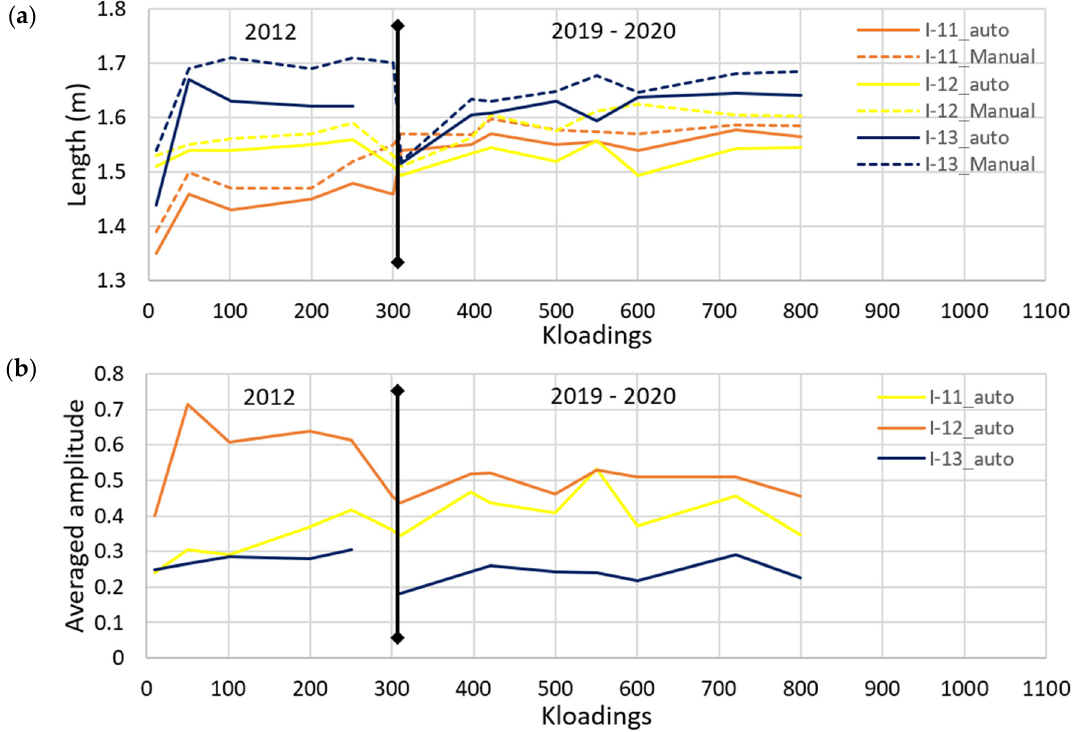
Figure 15. ( a ) Extensions and ( b ) averaged normalized amplitudes of 2.6 GHz RW on defects I-11 to I-13.